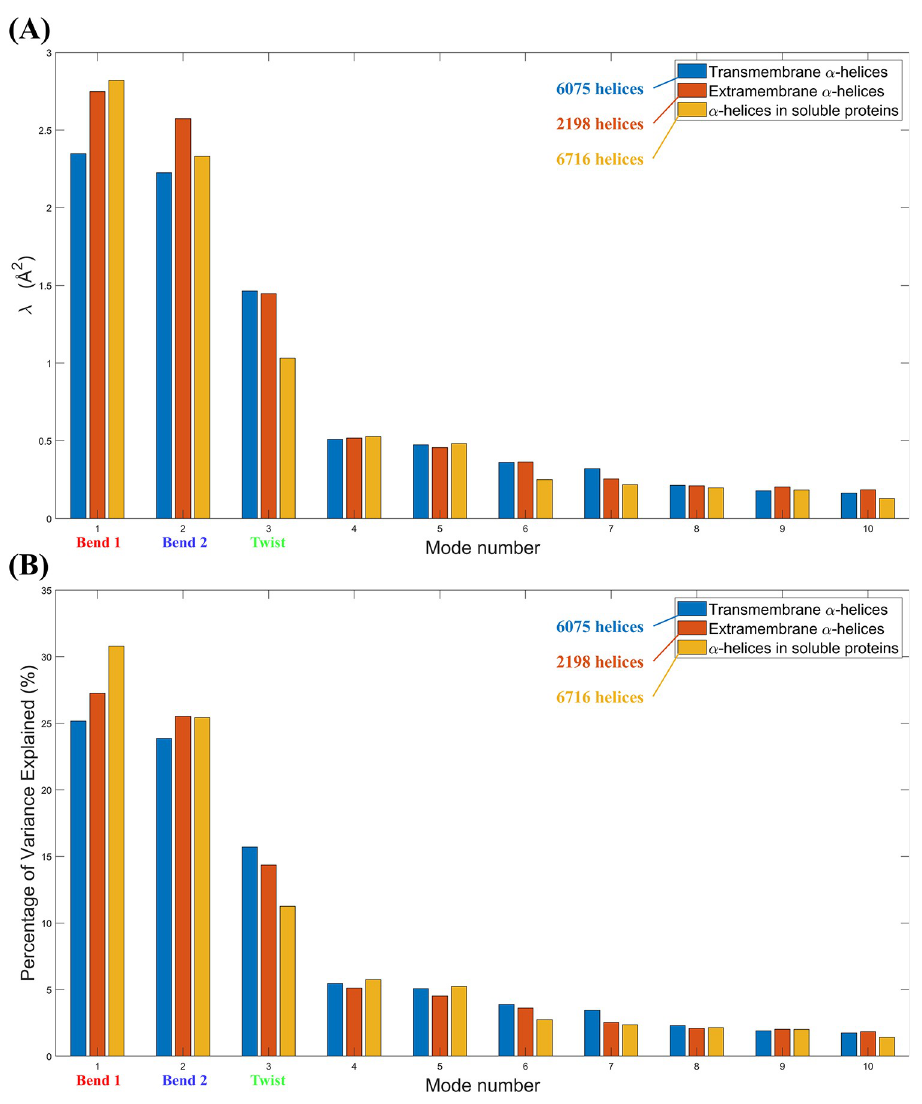
Fig 2. The ten principal components with the largest eigenvalues ( λ ) from 18-residue transmembrane α -helices ( N = 6075), extramembrane α -helices ( N = 2198), and α -helices in soluble proteins ( N = 6716). (A) The eigenvalues ( λ ). (B) The eigenvalues, when normalized by total